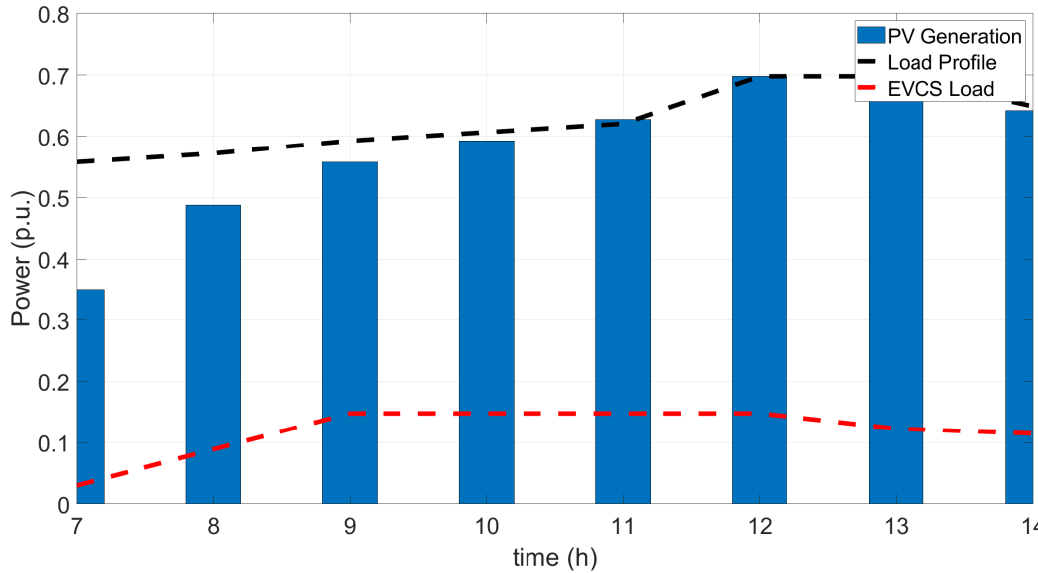
Figure 2. Hourly variations of active powers for PV generation, EVCS load, and demand over the course of dispatch. Table 2. Locations and power ratings of PV resources.